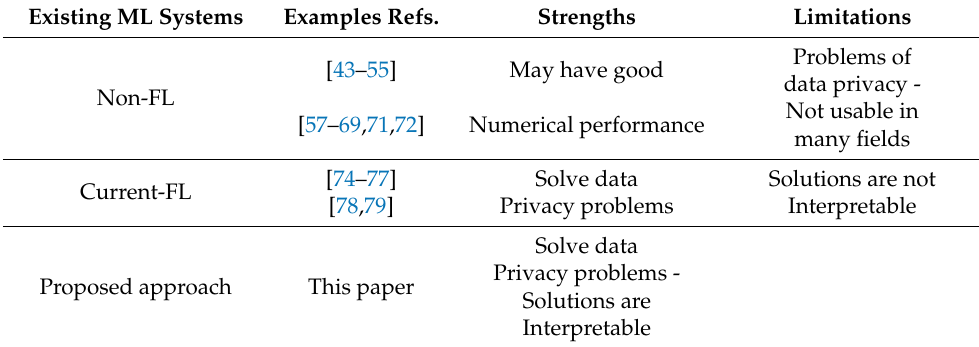
Table 1. Review summary and positioning of our paper in the